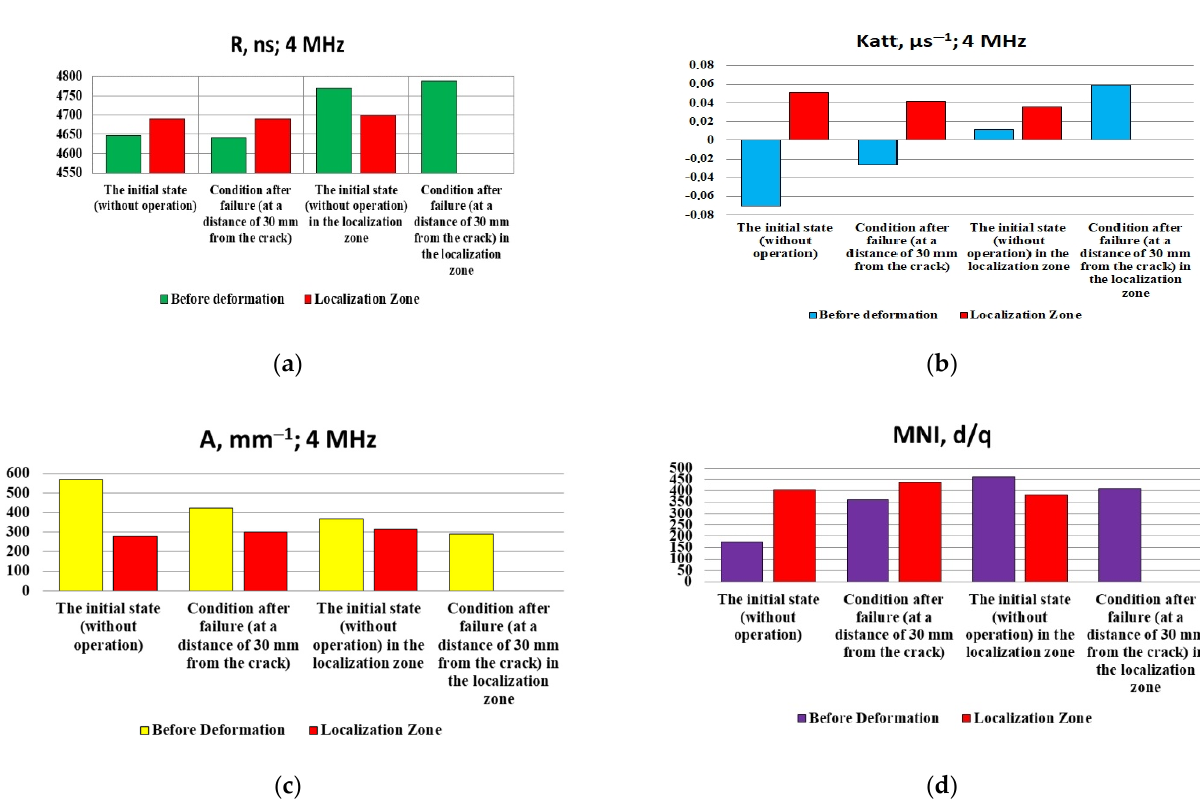
Figure 13. The results of measuring the acoustic and magnetic characteristics of the investigated samples of heat resistant 0.12C-1Cr-1Mo-1V steel before deformation and in the zone of localization of deformation: ( a ) is the delay time of the surface acoustic wave (the measurement error of each structural component is ± 2.5%); ( b )—attenuation coefficient of the surface acoustic wave (the measurement error of each structural component is ± 2.5%); ( c )—the amplitude of the received signal of the surface acoustic wave (the measurement error of each structural component is ± 2.5%); ( d )—intensity of magnetic noise (the measurement error of each structural component is ± 3.5%)